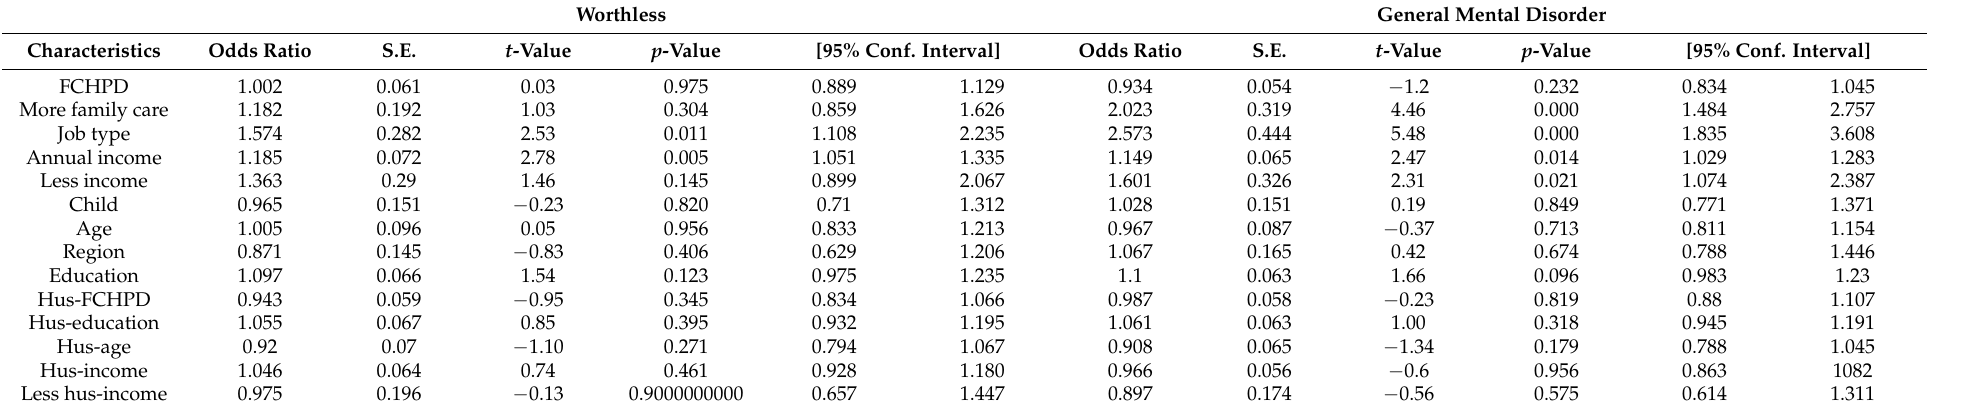
Table A3. Ordinal logistic regression of worthless effect and general mental disorder with different factors in the total